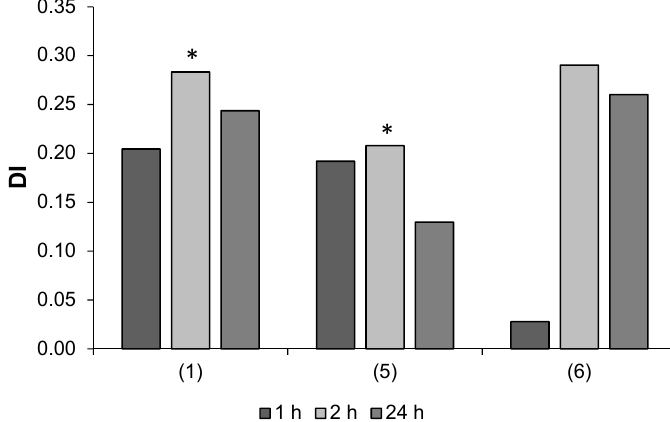
Figure 1. Settling success of Myzus persicae on Brassica rapa subsp. pekinensis. exposed to cis -jasmone (1), 7,8-epoxyjasmone (5), and hydroxy-7,8-epoxyjasmone (6). The same plant species was used to maintain the aphid stock culture. Relative index of deterrence (DI) after 1, 2, and 24 h. ‘*’Asterisks indicate statistically significant differences between the numbers of aphids on control and treated leaves at p < 0.05 (one ‐ way ANOVA).